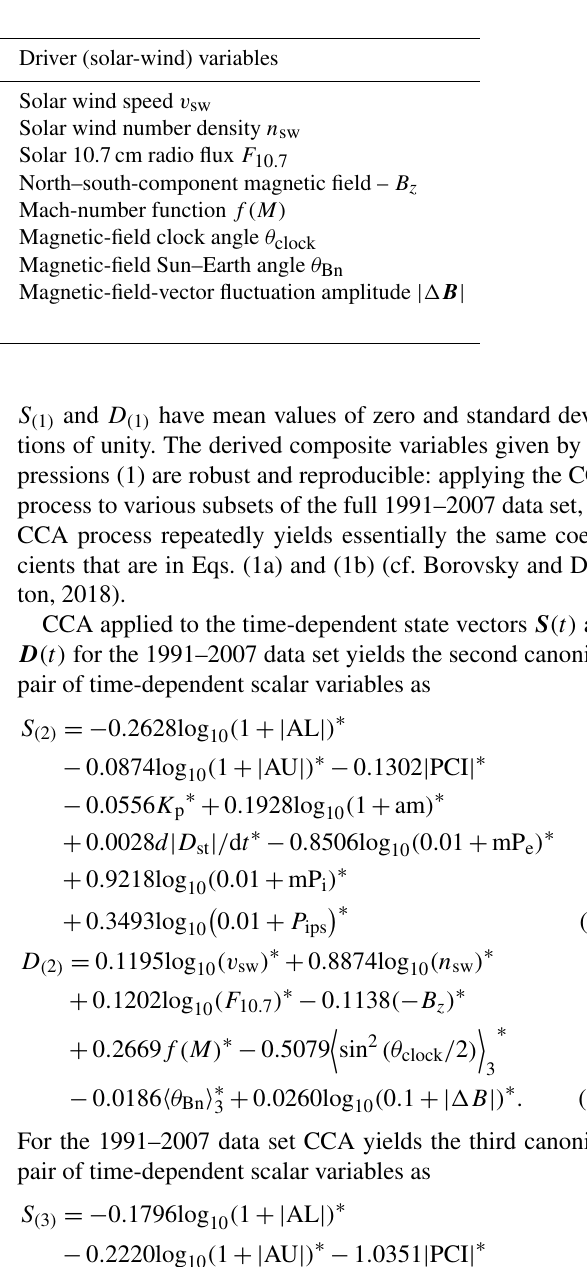
Table 1. The nine time-dependent variables going into the system state vector S (t) of the magnetosphere and the eight time-dependent variables going into the driver state vector D (t) of the solar